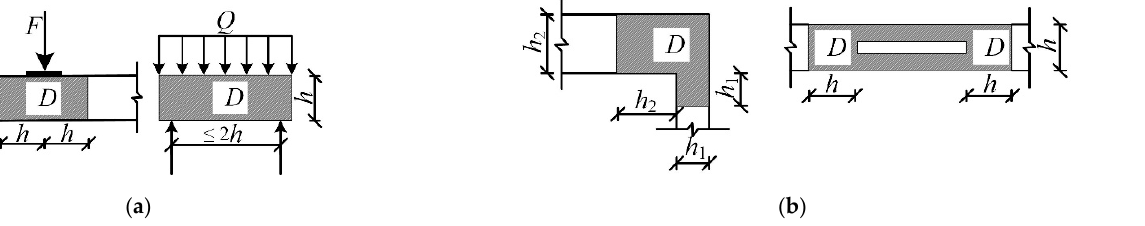
Figure 2. Discontinuity region of load or geometry: ( a ) load discontinuous region; ( b ) load discontinuous region.